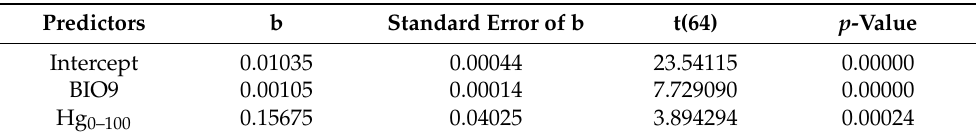
Table 6. Regression summary for Hg content in pine foliage (mg kg − 1 ) as the dependent variable, and BIO9 ( ◦ C) and Hg content (mg kg − 1 ) in the 0–100 cm soil layer as independent variables; R 2 adj. = 0.53; F (2.64) = 38.609; p <